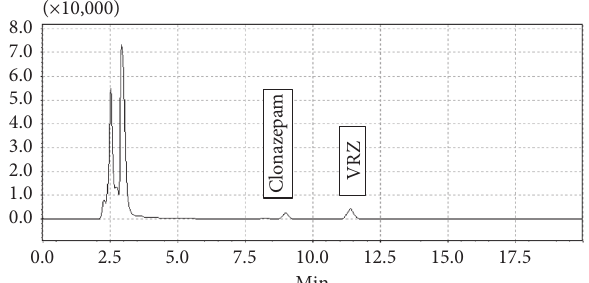
Figure 1: Chromatogram obtained from a patient on voriconazole (VRZ) therapy.